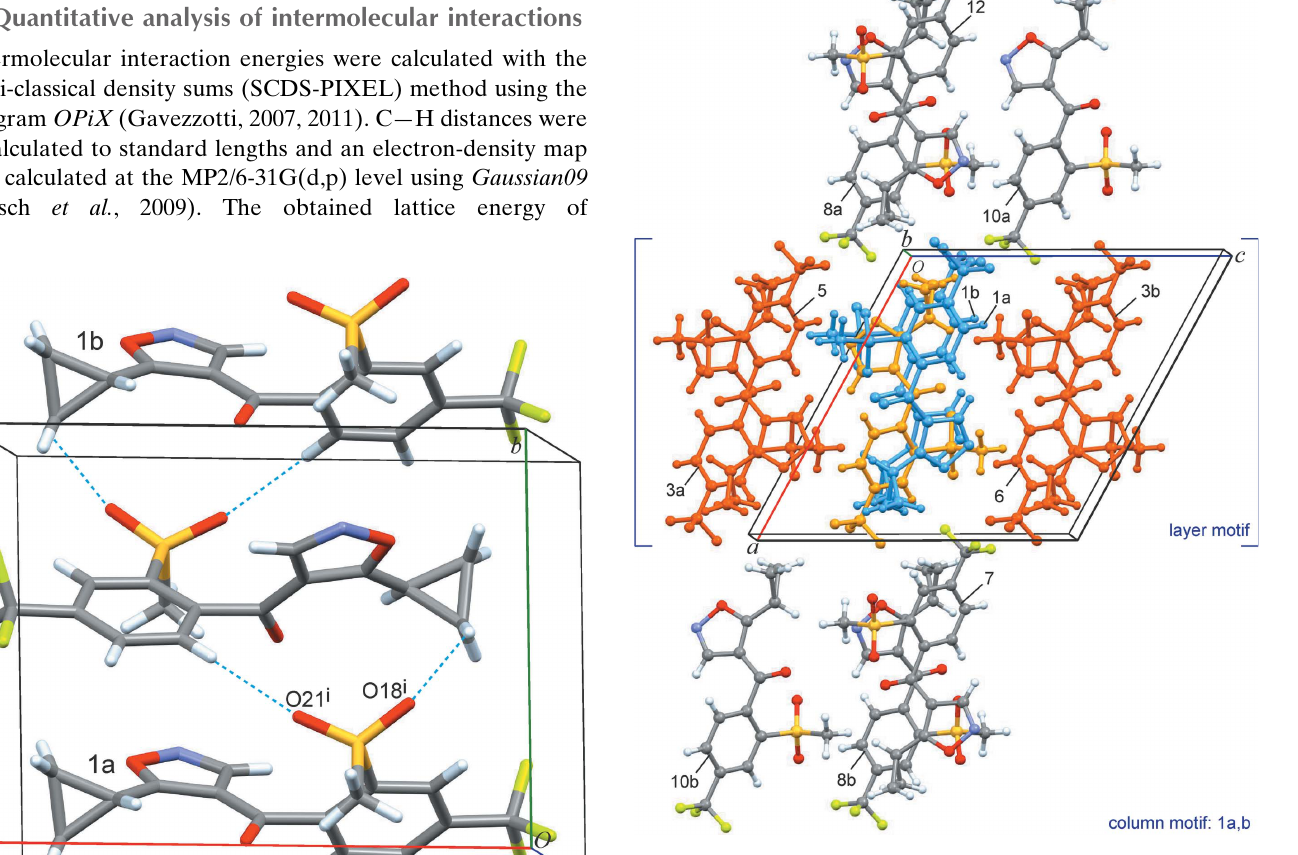
Figure 4 Cluster consisting of a central molecule (orange) and neighbouring molecules representing the twelve most important molecule/molecule interactions (see Table 3). The interactions 1a,b (blue molecules) constitute a column along the twofold screw axis, whilst 3a,b, 5 and 6 are interactions between adjacent columns related by a c glide mirror